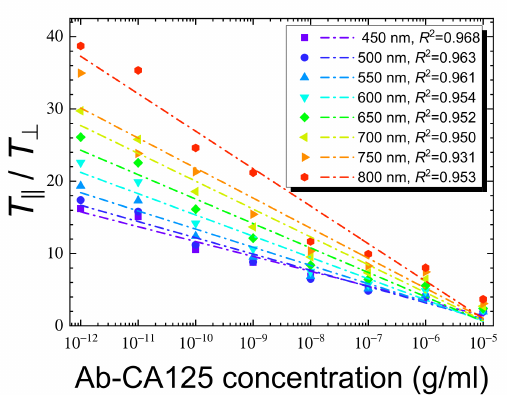
Figure 8. The correlation between the concentration of the anti-CA125 antibody and the ratio of reduced transmittance derived from Figure 7. The T (cid:107) / T ⊥ ratios were calculated and plotted against the concentration of the anti-CA125 antibody at selected wavelengths of 450, 500, 550, 600, 650, 700, 750, and 800 nm. The coefficient of determination, R 2 , for each regression line is given in the legend as a measure of the agreement with the linear